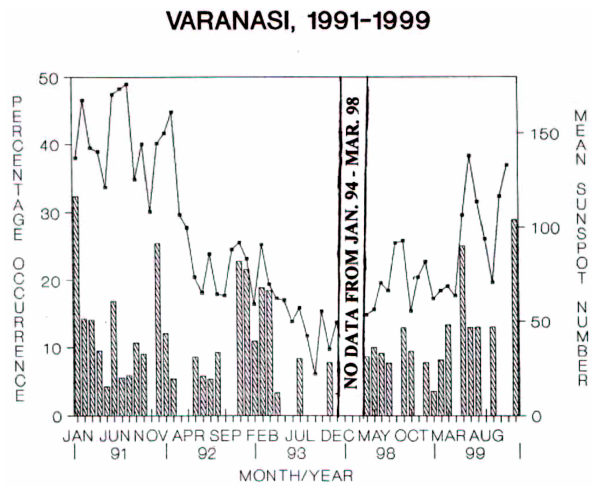
Fig. 3. The month-to-month variation of the mean percentage oc- currence of scintillations and sun spot numbers for the years January 1991 − December 1993 and April 1998 − December 1999 are shown.